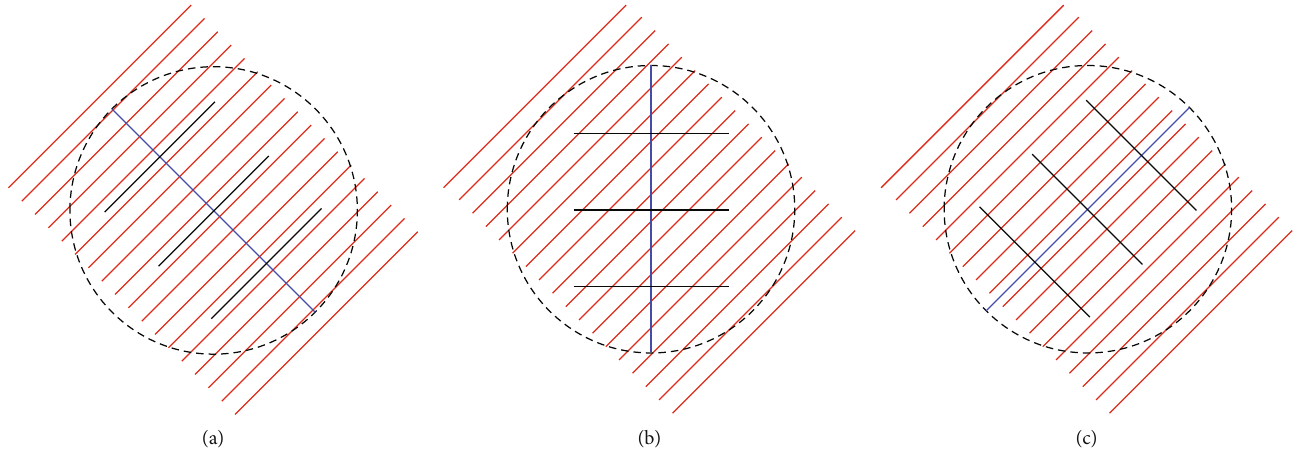
Figure 12: Simpli fi ed models considering di ff erent well placement strategies: (a) FC = 0 ; (b) FC = 0 : 5 ; (c) FC = 0 : 67